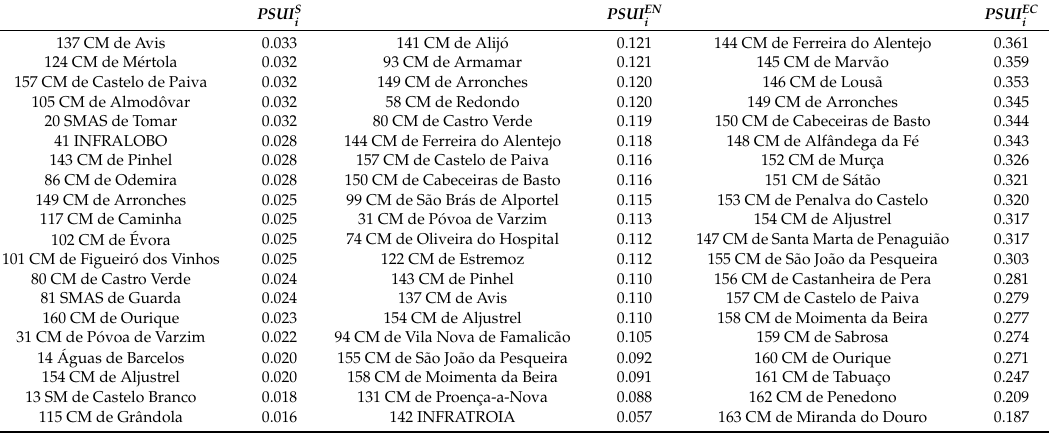
Table 4. Bottom 20 water companies for each